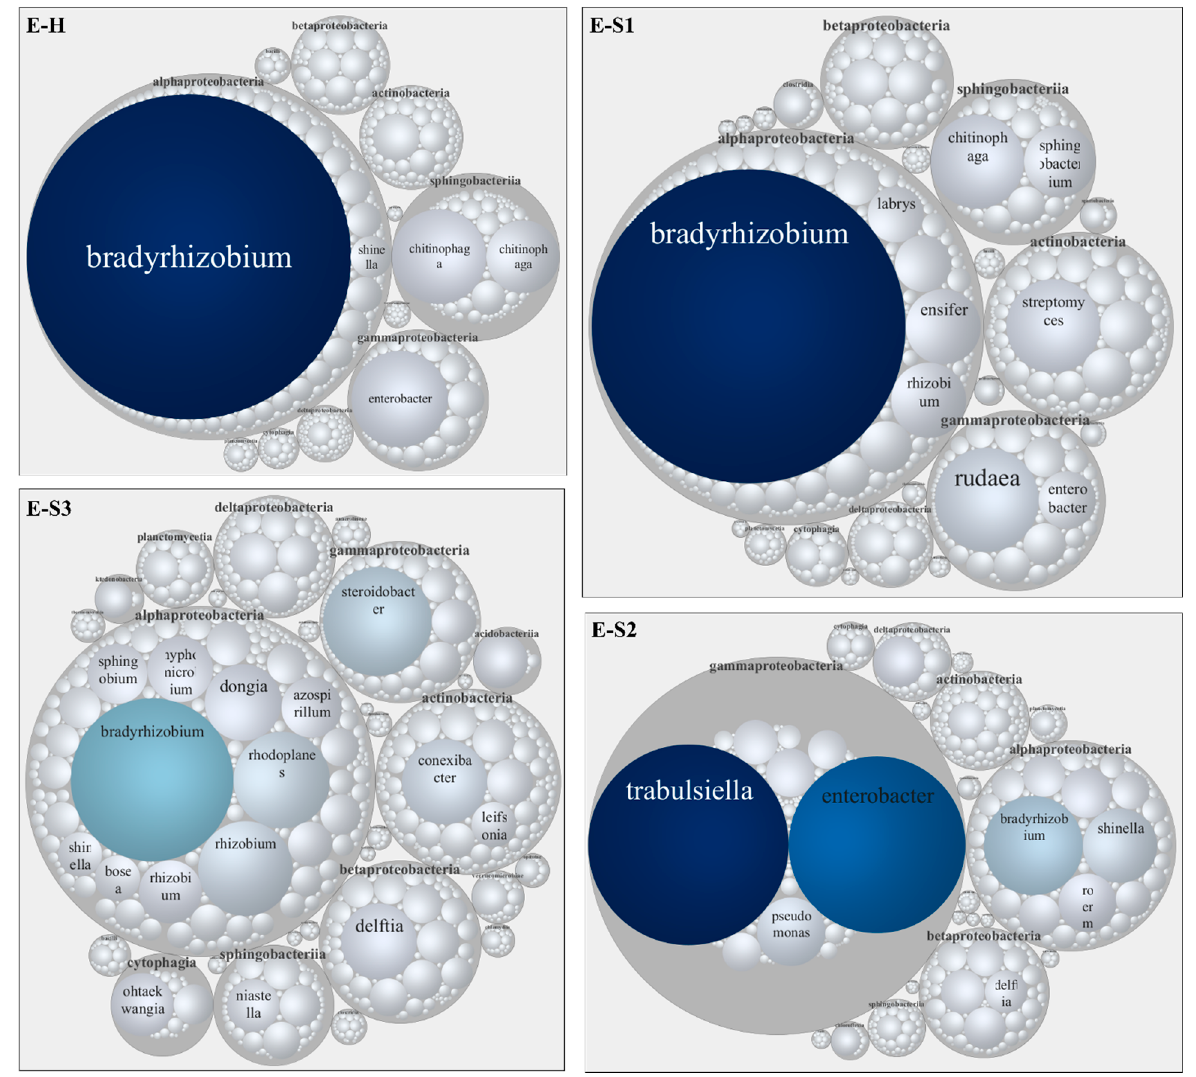
Figure 6. Taxonomic circular maps of soybean bacterial root endophytes. Taxonomic analyses of the endophytes (E) in healthy (H) and TRD-affected roots (S1 to S3) are based on 16S rRNA sequencing and OTUs with the highest abundance ( n > 0.2%). The taxa are grouped by class; the labels show the most abundant genera. The size of the map circles is proportional to the reads number. Numbers depict percentages of selected taxonomical categories.